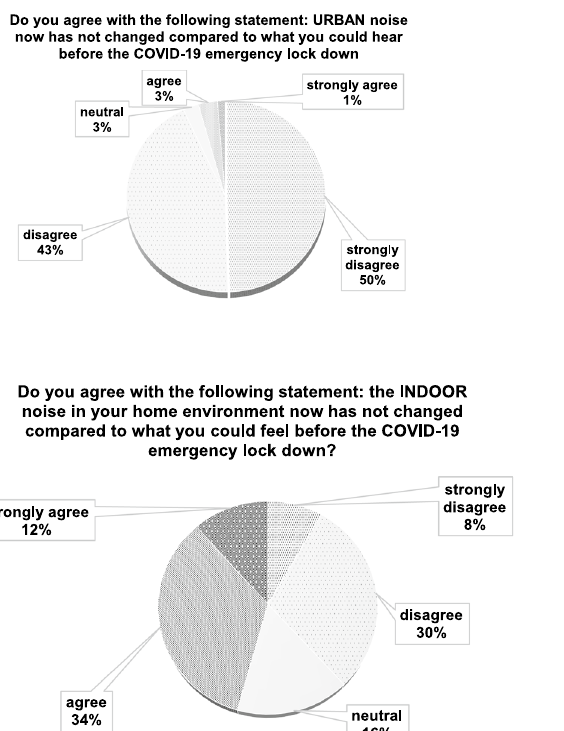
Figure 6. Italian results: comparison between indoor and outdoor noise variation perception.